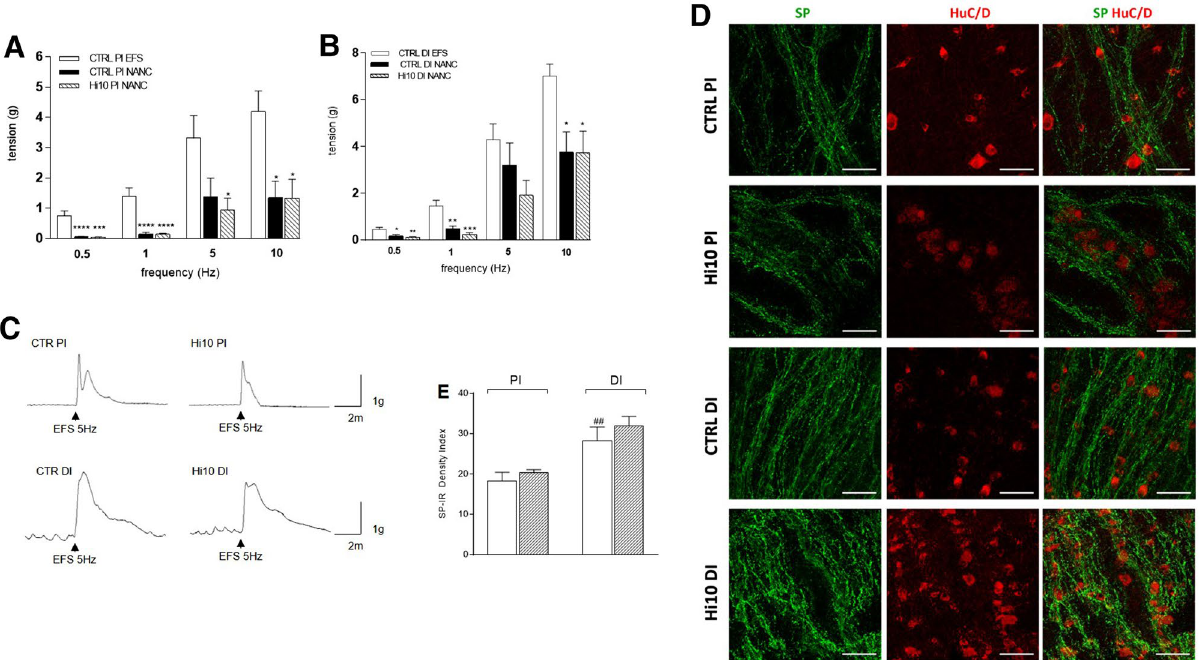
Figure 5. NANC contractions of both proximal (PI) and distal (DI) gilthead sea bream in CTRL and Hi10 fish. Contractile effect of increasing EFS frequencies in in the presence of atropine (1 µM) and guanethidine (1 µM) in the proximal ( A ) and distal intestine ( B ) of fishmeal diet (CTRL) and insect diet (Hi10) fed animals. Data obtained in NANC conditions are compared to EFS-evoked contractions in non-NANC conditions and are reported as mean ± SEM, N = 5 fish/group. Difference significance: **** P < 0.0001, *** P < 0.001, ** P < 0.01, * P < 0.05 vs respective CTRL frequency of stimulation in non-NANC conditions, by one-way ANOVA with Sidak’s post-hoc test. ( C ) Representative tracings of 5 Hz EFS-evoked intestinal contractions in NANC conditions in the different experimental groups ( D ) Representative confocal microphotographs showing the distribution of SP (green) and HuC/D (red) in gilthead sea bream myenteric plexus in the different experimental groups (N = 5 fish/group). Scale bars = 50 μm. ( E ) Density index of SP immunoreactivity in proximal and distal intestine whole-mount preparations obtained in the different experimental groups (N = 5 fish/group). Data are reported as mean ± SEM, N = 5 fish/group. Difference significance: ## P < 0.01 versus CTRL PI, by one-way ANOVA with Sidak’s post-hoc